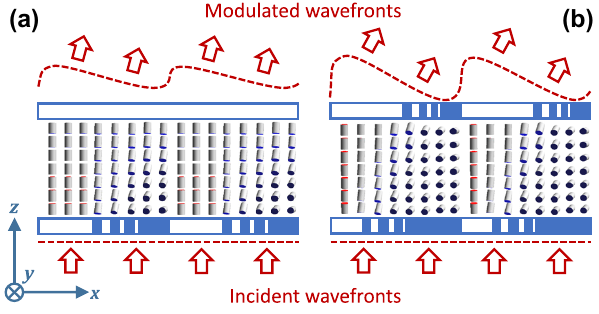
Figure1: SketchesofanomalouslightrefractionbyLC-metasurfaces self-assembling upon one patterned substrate (a) and between a pair of complementing patterned substrates (b). Substrate areas promoting vertical LC alignment are depicted in